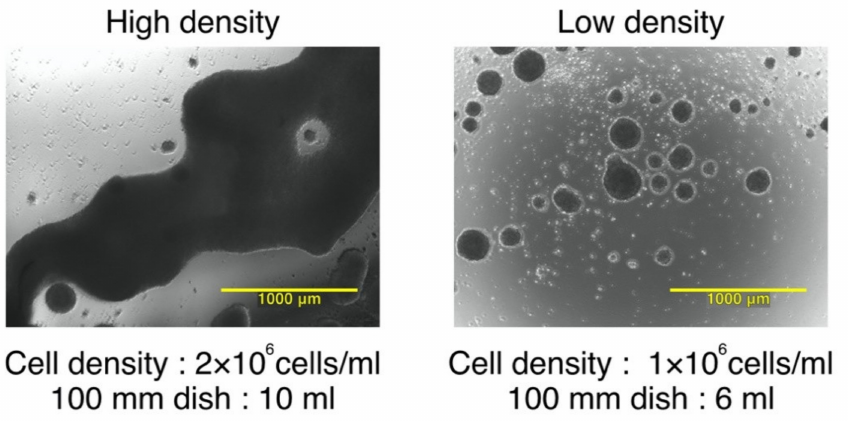
Figure 1. Comparison of cluster formation at the different seeding densities and the number of cells used during DC maturation. Observation of cluster morphology by phase − contrast microscopy of DCs seeded at high (2 × 10 6 cells/mL) and low (1 × 10 6 cells/mL) densities. The yellow bars indicate 1000 µ